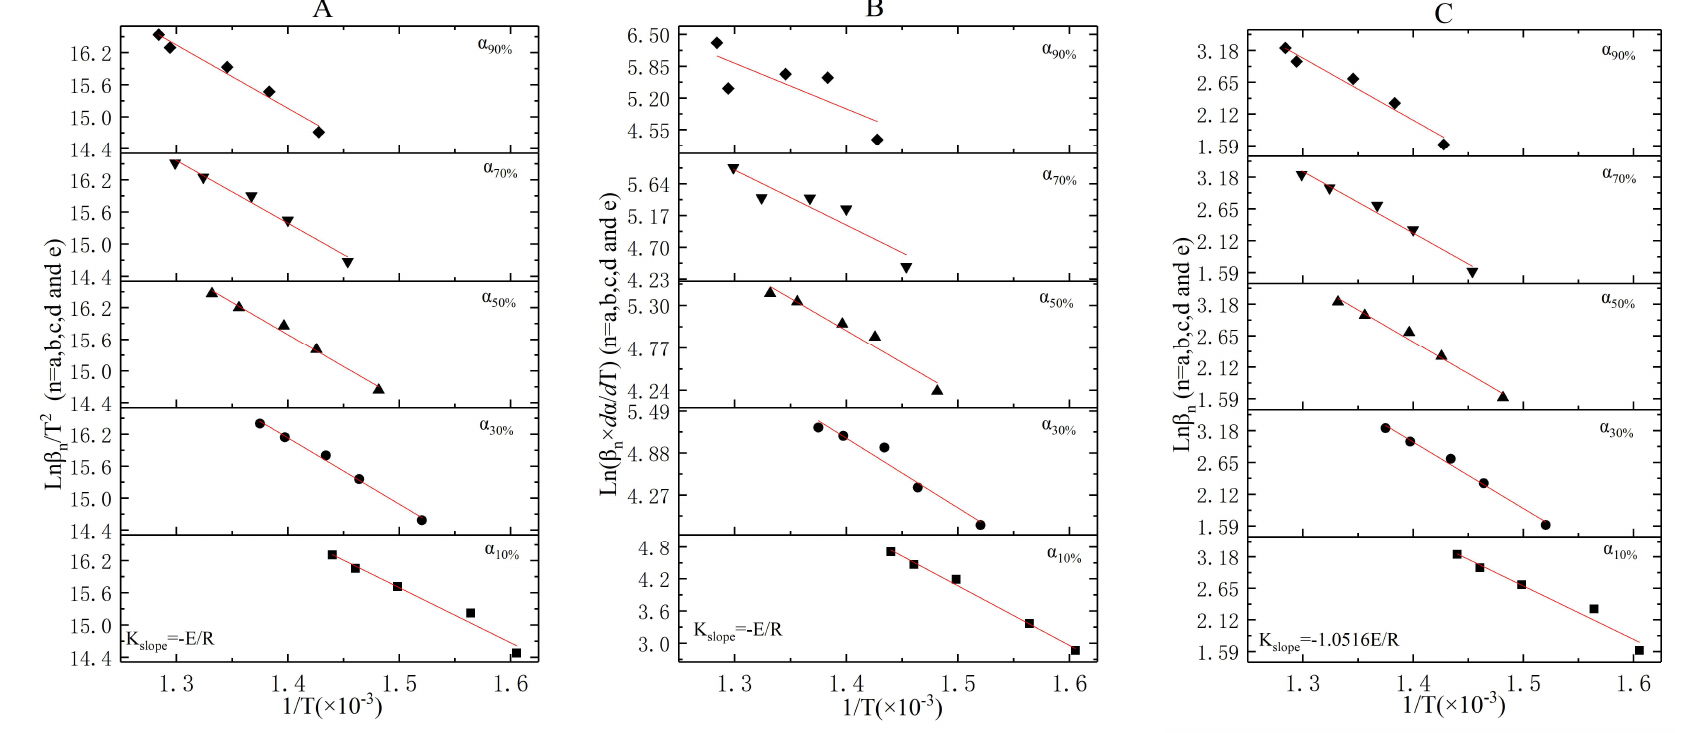
Figure 5. The linear fitting results for Stage 3 under the KAS, Friedman, and FWO methods (( A )—KAS method, ( B )—Friedman method, and ( C )—FWO method).